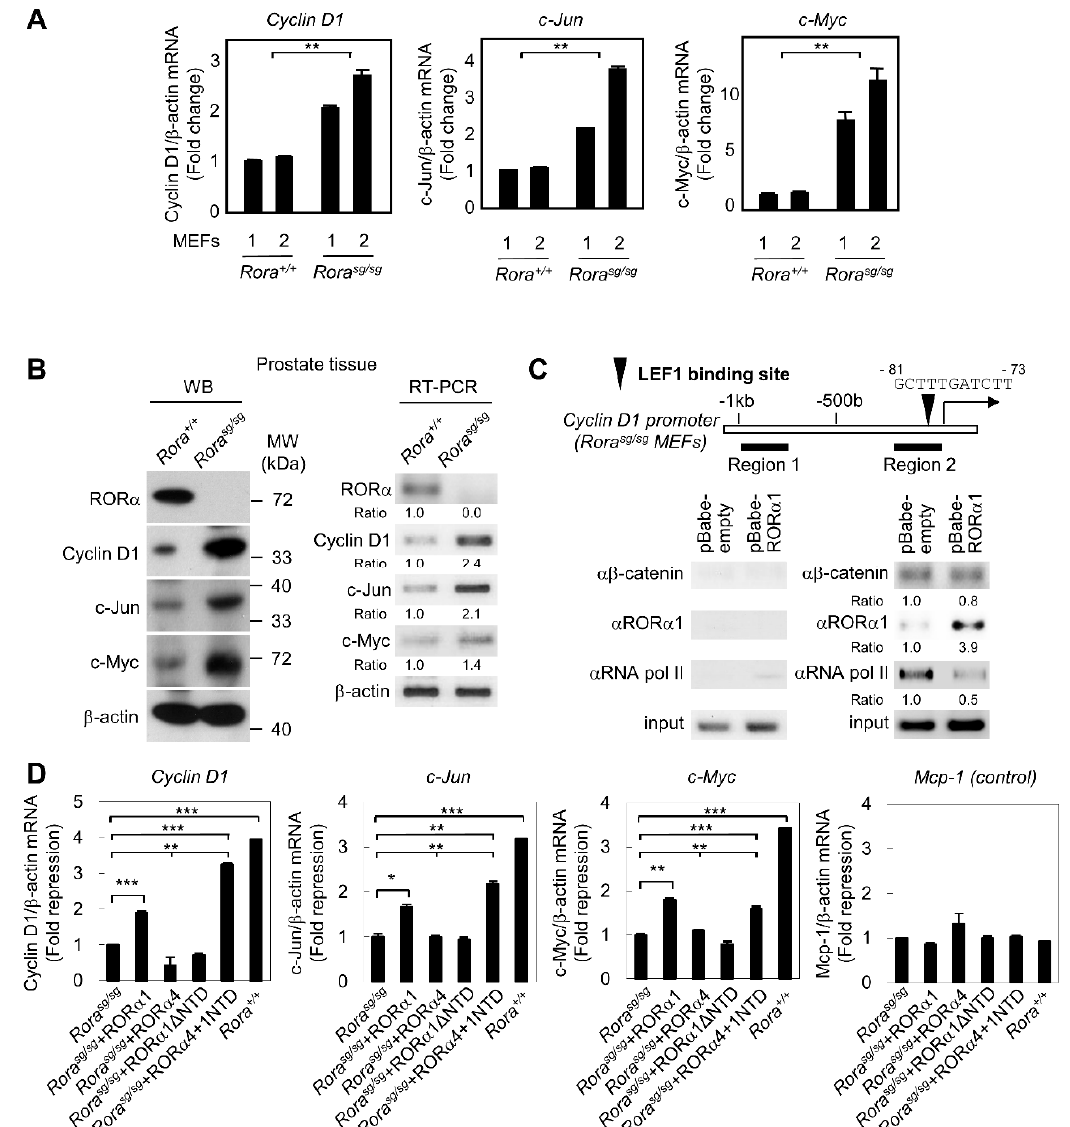
Figure 2. ROR α 1 transcriptional repressive function on Wnt target genes in MEFs. ( A ) Real-time quantitative RT-PCR analysis of cyclin D1 , c-jun , and c-myc was performed on primary mouse embryonic fibroblasts prepared from two independent Rora +/+ ( Rora +/+ 1 and Rora +/+ 2) or Rora sg/sg ( Rora sg/sg 1 and Rora sg/sg 2) mice (mean ± SD, n = 3). The p value was calculated by one-way ANOVA (** p < 0.01). ( B ) Immunoblotting and RT-PCR analyses of ROR α 1 and Wnt target genes in prostate tissue from Rora +/+ and Rora sg/sg mice. ( C ) ChIP assay on the cyclin D1 promoter from Rora sg/sg MEFs. Cells were either infected with control retrovirus (pBabe-empty vector) or infected with retrovirus expressing ROR α 1 (pBabe-ROR α 1). Occupancy of the cyclin D1 promoter by β -catenin, ROR α 1, and RNA polymerase II is indicated. The upper illustration represents the location of the LEF1 binding site on the Cyclin D1 promoter. The proposed model of ROR α 1 serving as a co-repressor for β -catenin transcriptional activity on the promoter of the target gene, Cyclin D1 (right panel). ( D ) Real-time quantitative RT-PCR analysis of cyclin D1 , c-jun , c-myc, and Mcp-1 was performed on Rora sg/sg , Rora sg/sg reconstituted with ROR α 1, ROR α 4, ROR α 1 ∆ NTD, ROR α 4 + 1NTD, and Rora +/+ MEFs (mean ± SEM, n = 3). The p value was calculated by a t-test (** p < 0.01, *** p < 0.001) or one-way ANOVA (** p < 0.01).